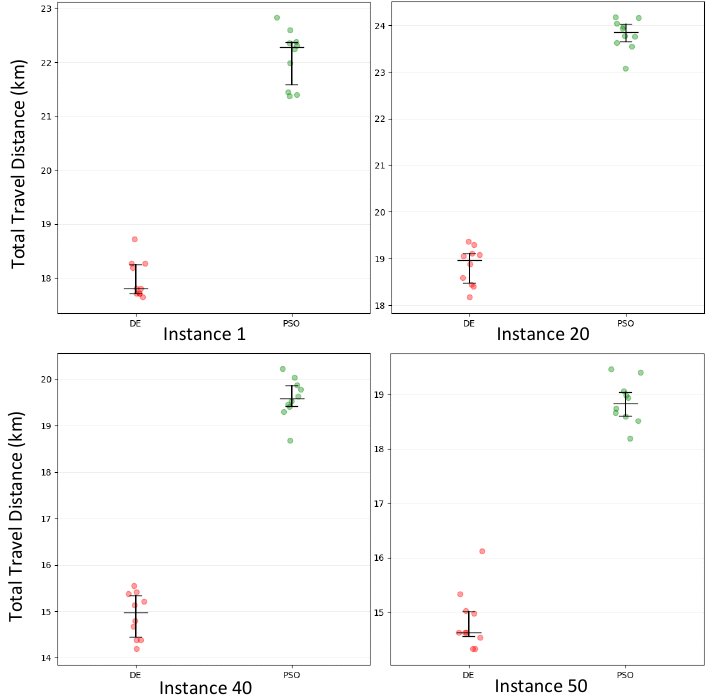
Figure 8. Box plot comparison of the total travel distance (km) from 10 replicated runs between the PSO and DE algorithms (instances 1, 20, 40 and 50).